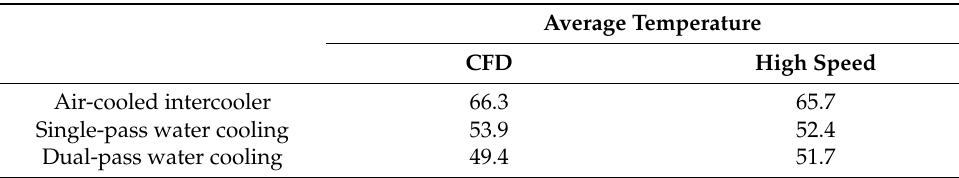
Table 5. Core volume comparison of charge air